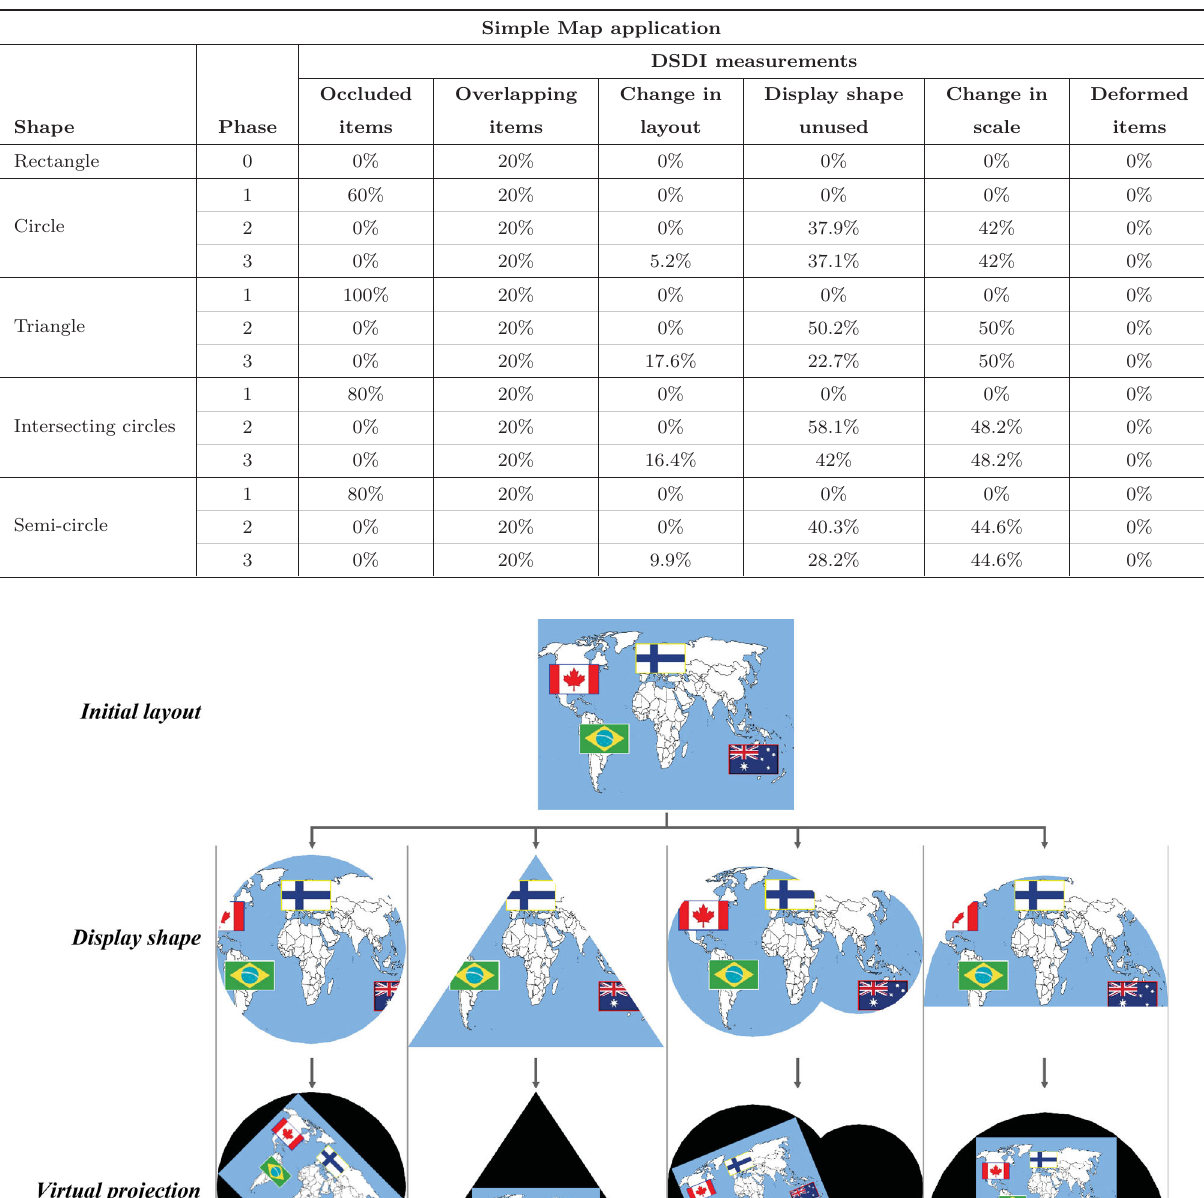
Table 2 DSDI measurements from the study in SynergyNet ’s Simple Map application